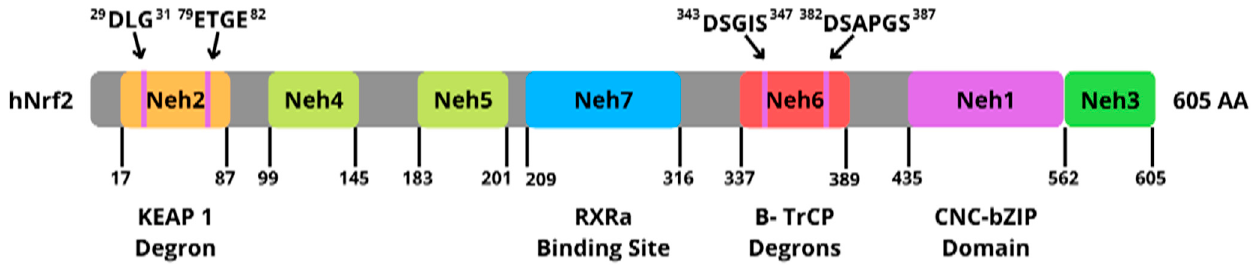
Figure 4. Domain structure of human Nrf2.